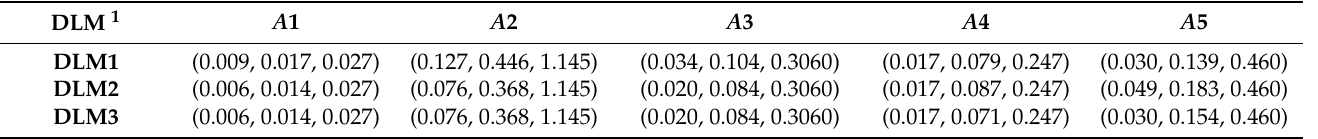
Table 7. Weighted normalized fuzzy decision matrix for three distance learning course structure assessment by five criteria. DLM 1